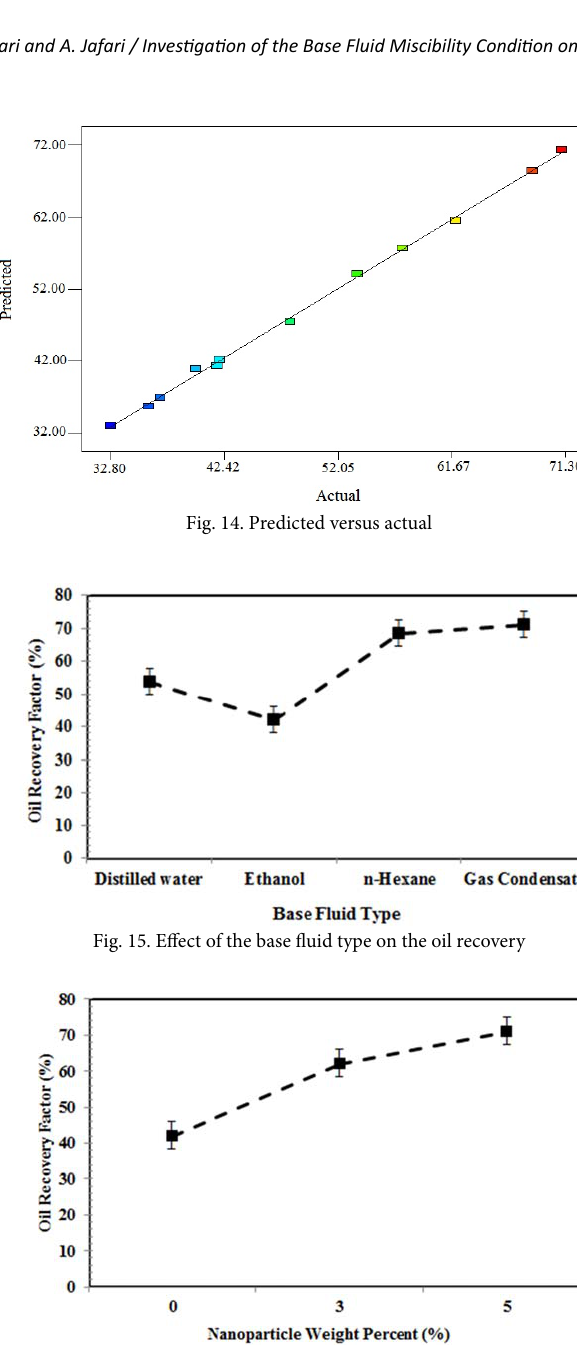
Fig. 16. Effect of nanoparticle’s weight percent on the oil